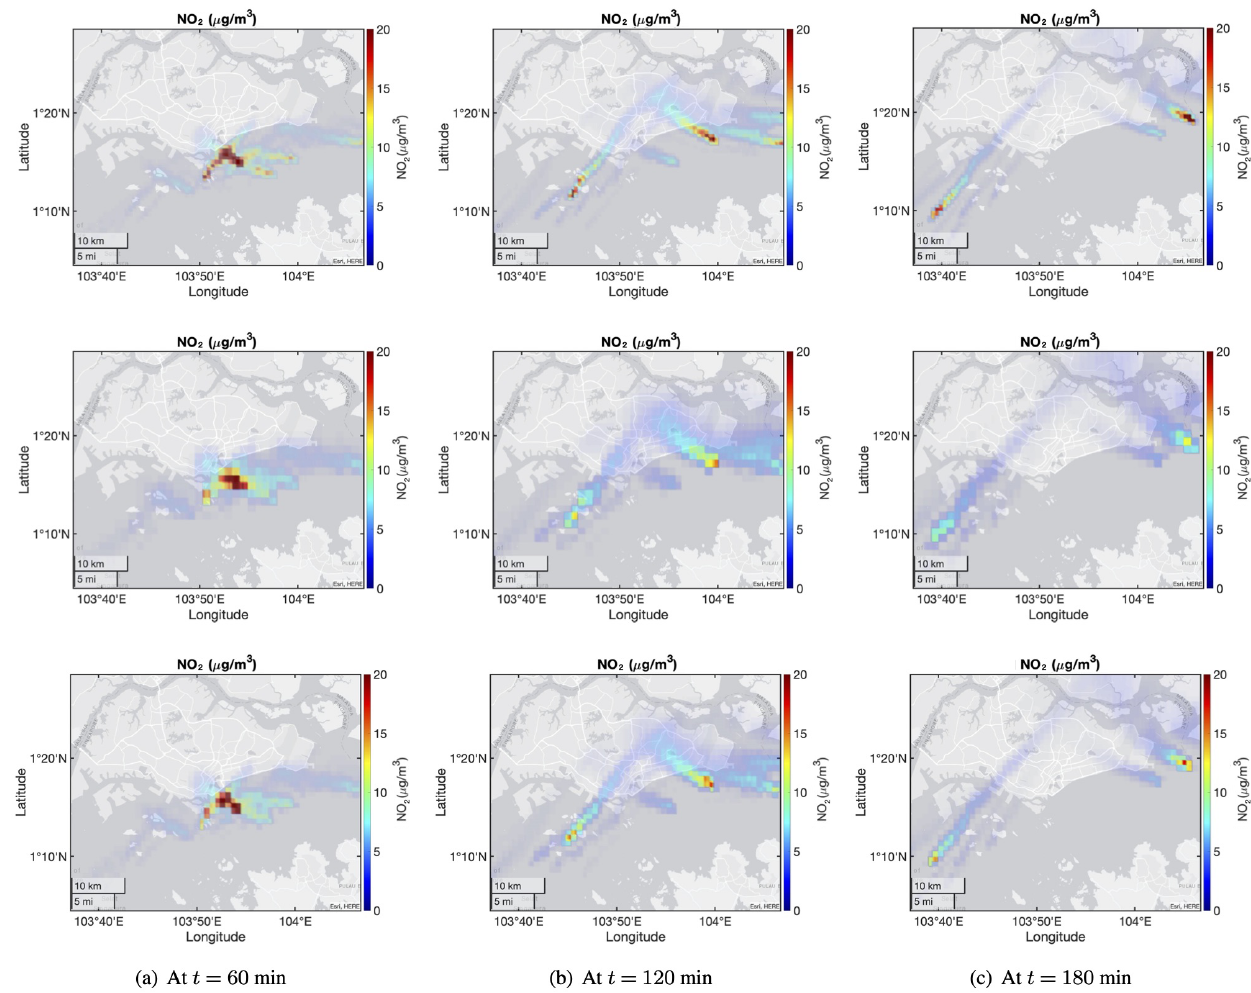
Figure B1. Instantaneous NO 2 concentrations near the ground by using different grid resolutions. Top row: d z = d y = 700m (case S3); middle row: d z = d y = 1400m (case S4); bottom row: small d z (case